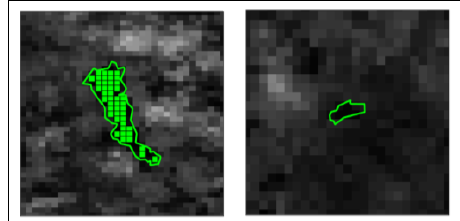
Figure 3: Outlines of the two target lakes (left: Sihl, right: St. Moritz) overlaid on VIIRS data. The clean pixels are shown as green squares. There exist no clean pixel for St. Moritz.